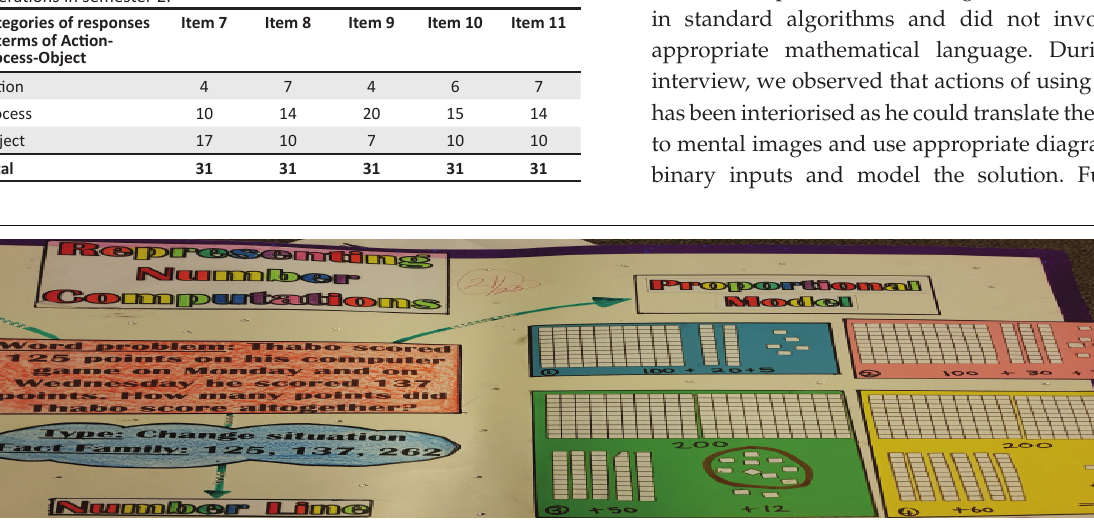
FIGURE 8: Sample of students’ written responses to item